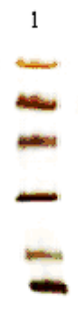
Figure 7. SDS-PAGE of lipase initial solution and filtered aqueous phase after emulsion preparation by membrane emulsification. Line 1: Standard solution; Line 2 represents the initial lipase solution at 2 g/L; Lines 3 represents the uncomplexed lipase present in the filtered aqueous phase of emulsion prepared using lipase solution of 2 g/L.